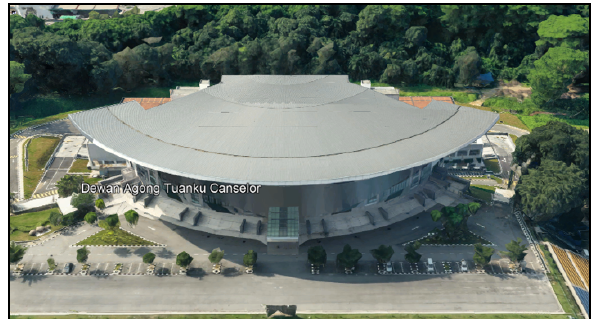
Figure 1. Dewan Agong Tunku Canselor in UiTM Shah Alam